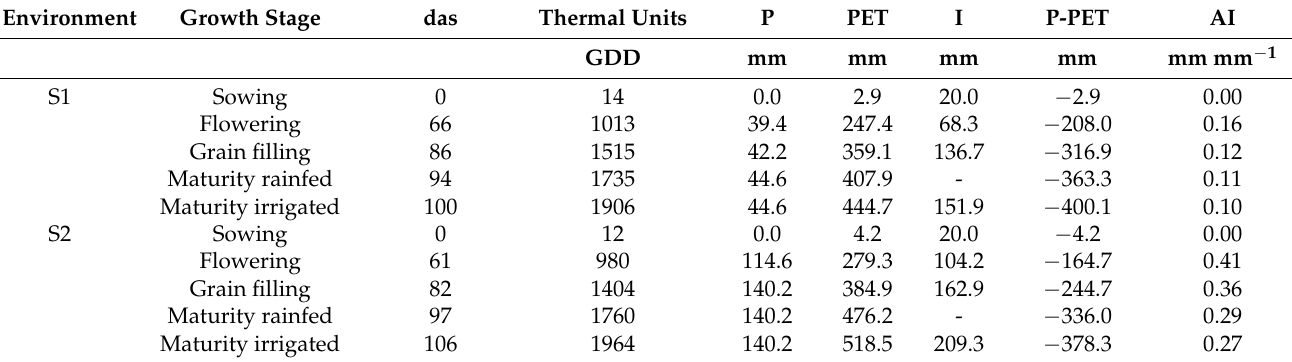
Table 3. Agrometeorological information on growth stages in terms of thermal units.